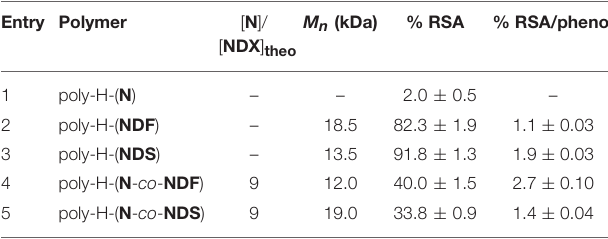
TABLE 6 | Radical scavenging ability of polymers and